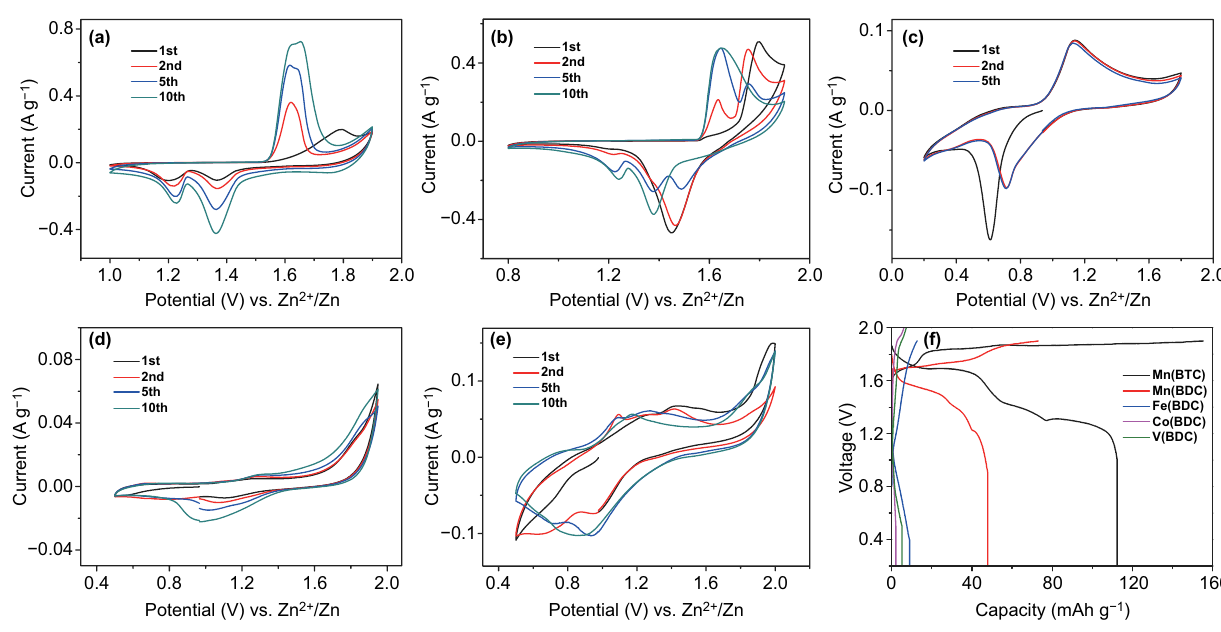
Fig. 2 CV curves at 0.5 mV s −1 of the MOF cathodes: a Mn(BTC), b Mn(BDC), c Fe(BDC), d Co(BDC), and e V(BDC), f Charge/discharge curves at 50 mA g −1 of the MOF